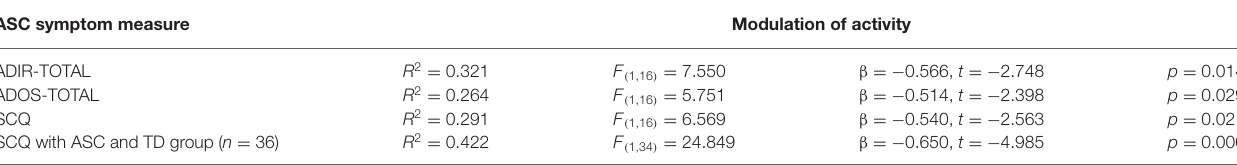
TABLE 5 | Overall model fit, beta values, t -values, and p -values are displayed for each diagnostic